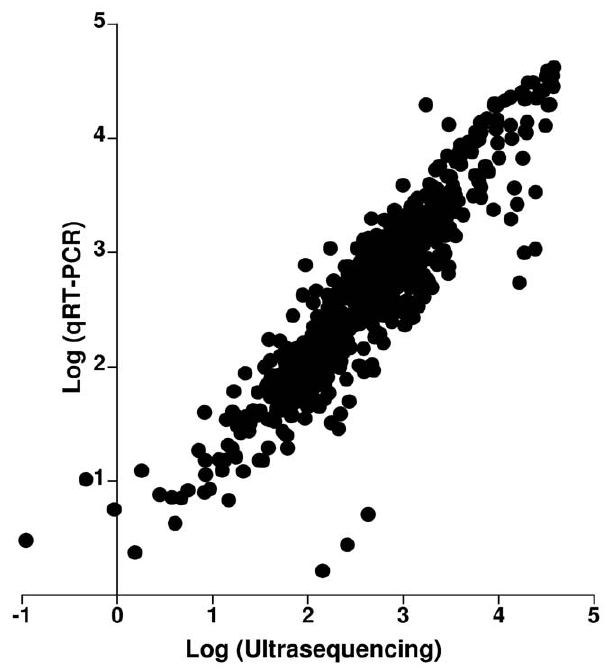
Figure 7. Correlation analysis between values obtained through ultrasequencing (abscises) and through qRT-PCR (ordinates). Pearsons coefficient is 0.9110 and R 2 =0.8299; p , 0.0001.